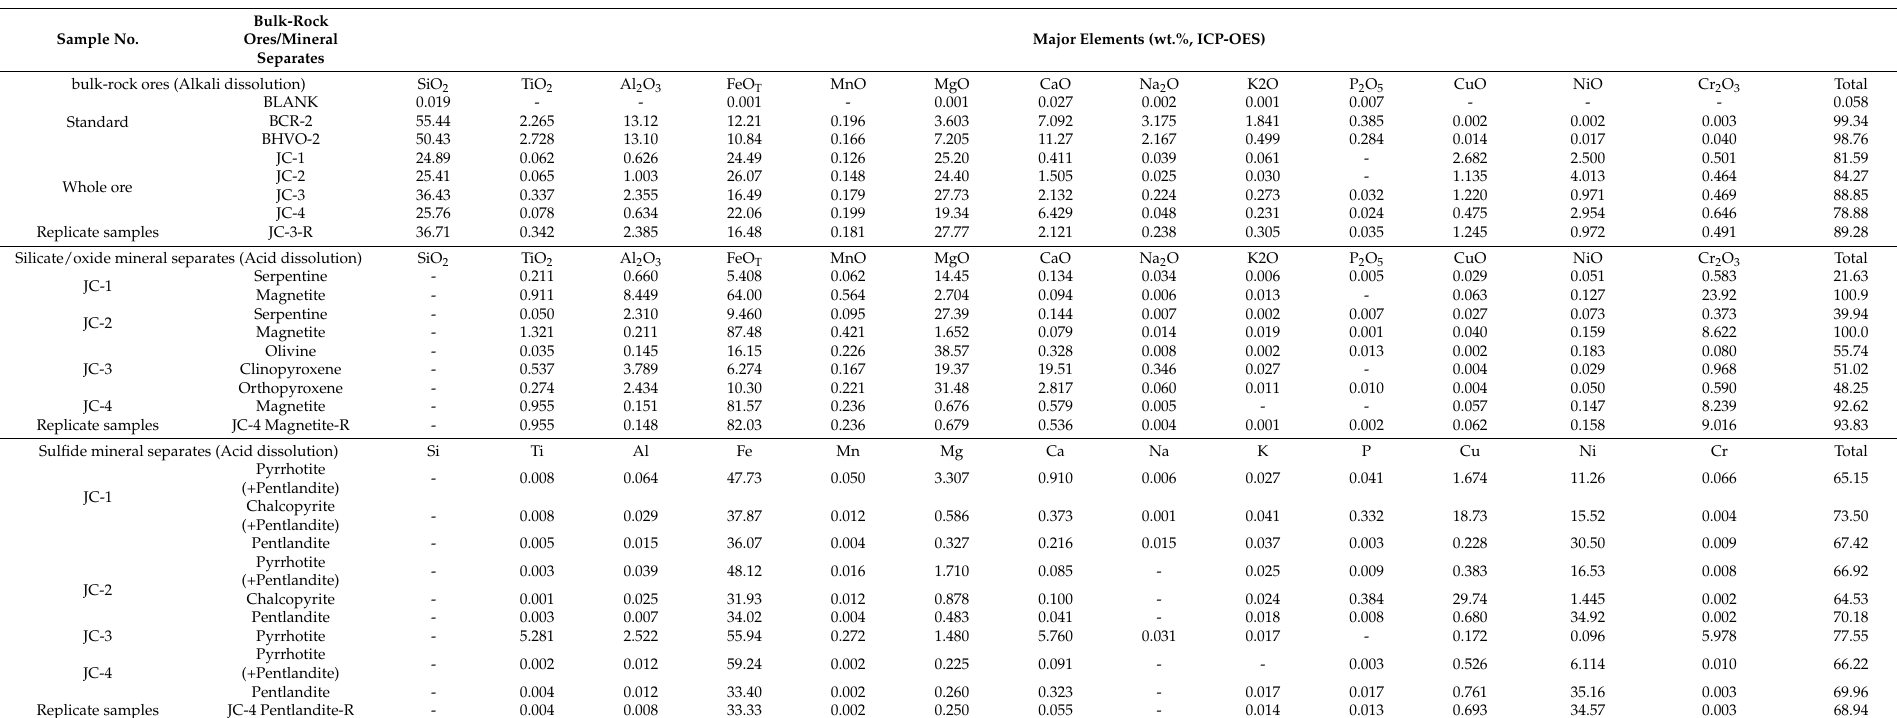
Table 4. Major and trace element compositions of bulk-rock ore samples and mineral separates in Jinchuan deposit by ICP-OES and ICP-MS, respectively. Sample